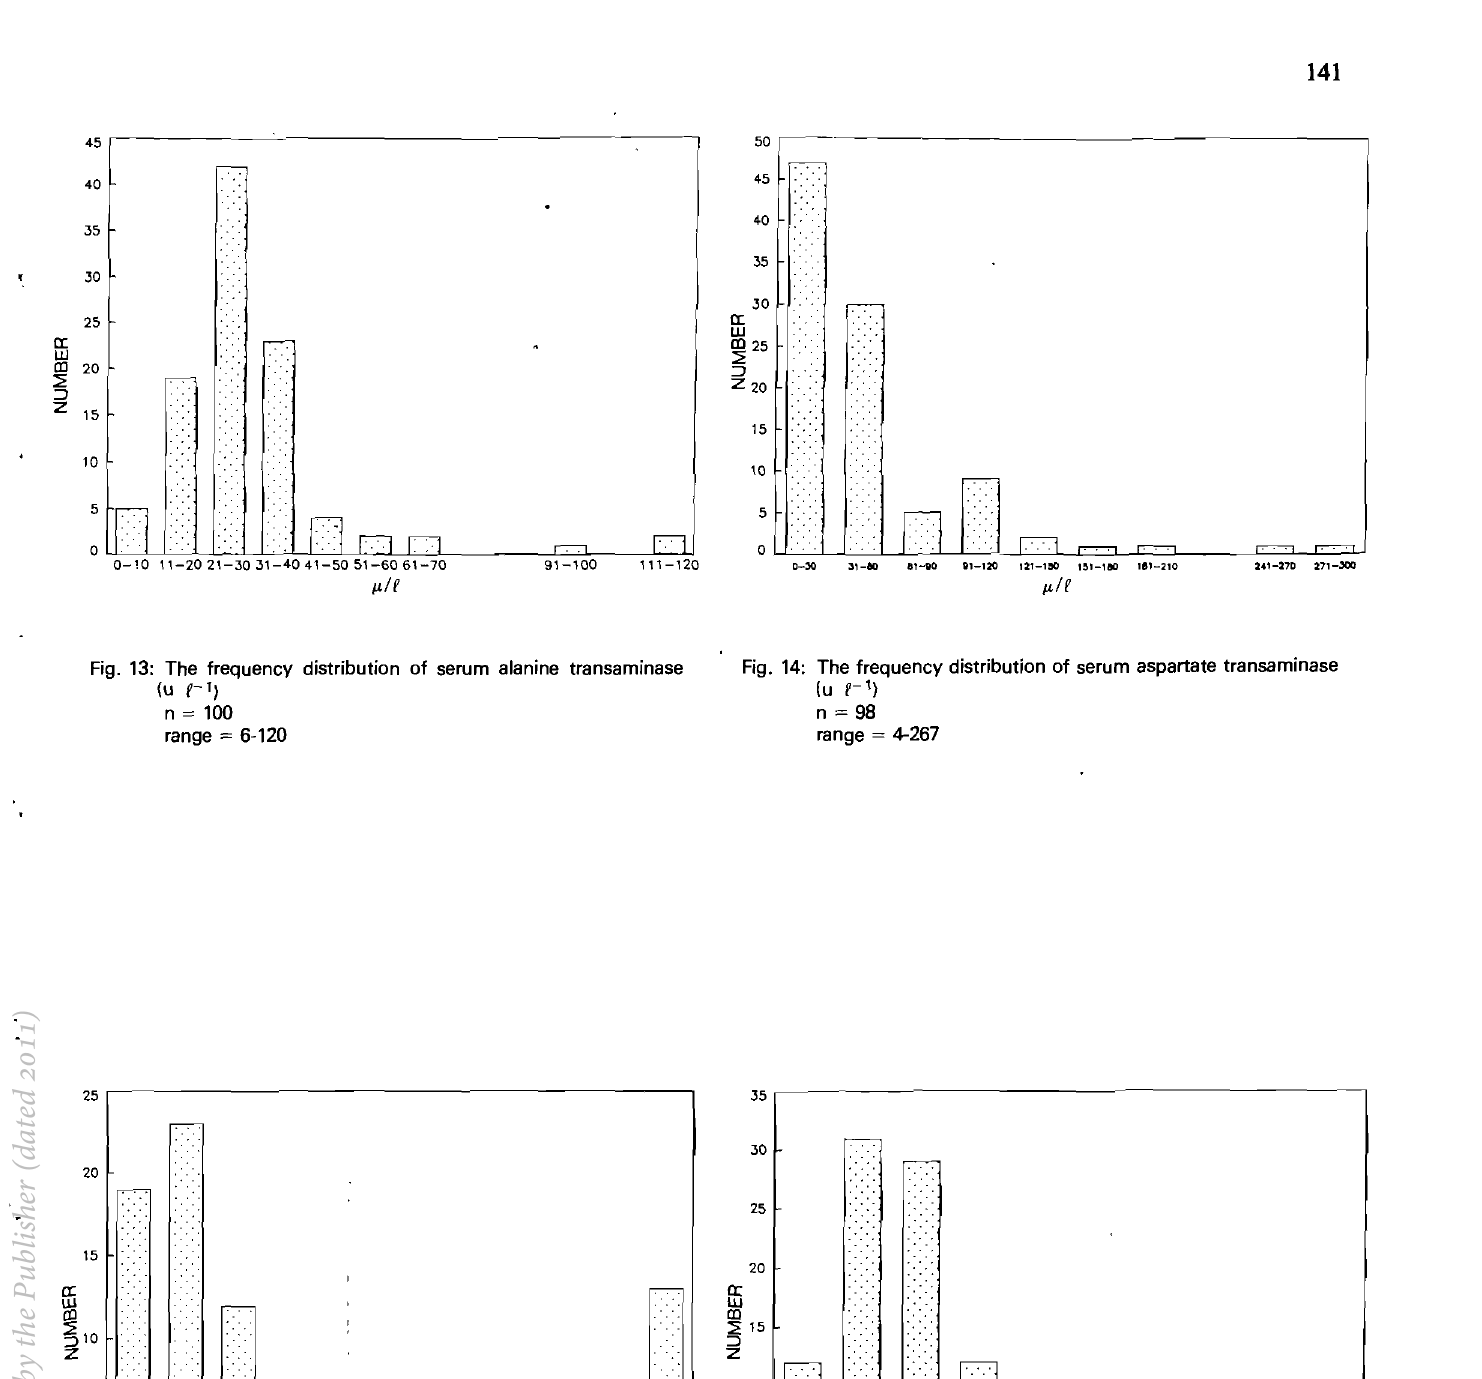
Fig. 16: The frequency distribution of serum gamma-glutamyltransfe rase (u f-T) n = 100 range =